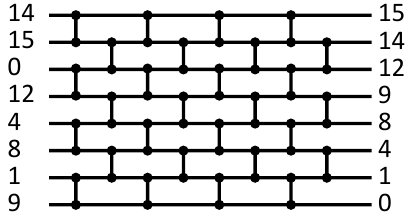
Fig. 2. Even-odd sorting network for the example in Fig. 1b.